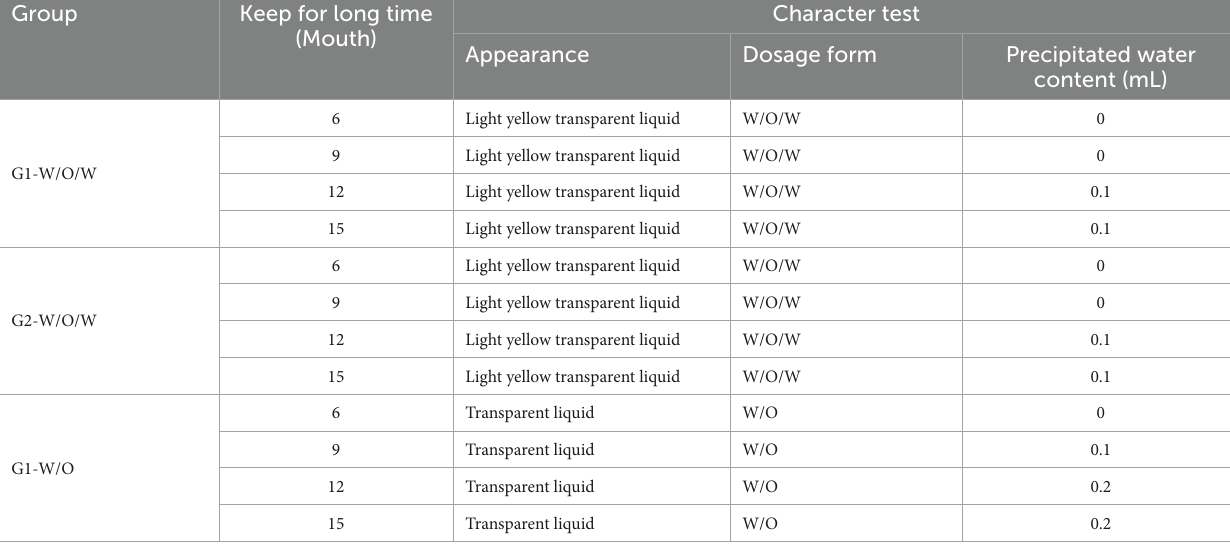
TABLE 1 The test results before vaccine preservation and after preservation at 4 ° C for different time. Group